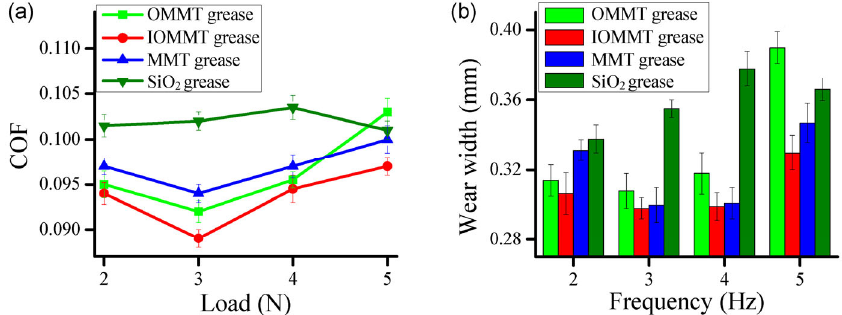
Fig. 7 The average COFs (a) and wear widths change (b) under the lubrication with insulating greases at different frequencies, 200 N, and